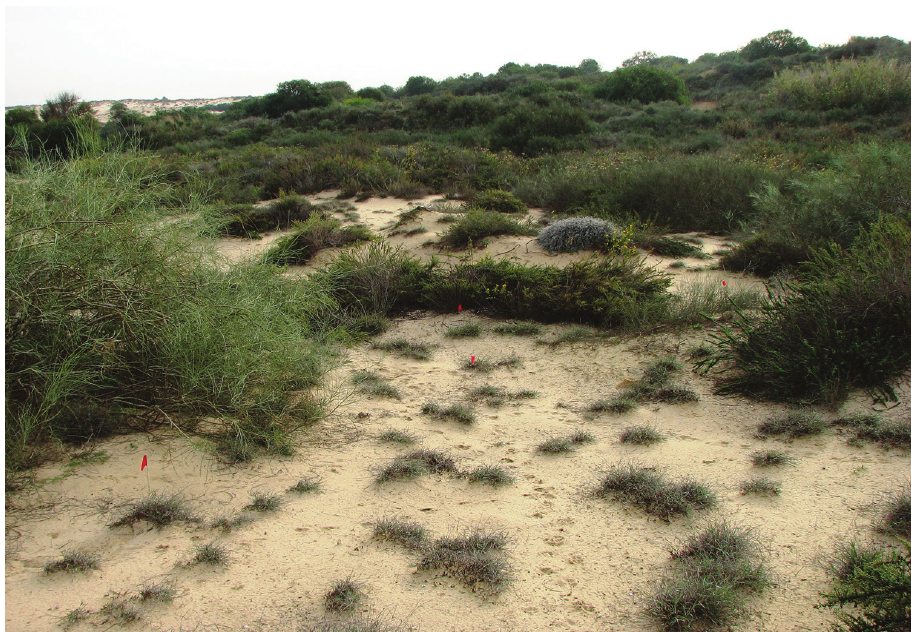
Figure 15. Habitat of Graphipterus sharonae sp. n.: Stabilized sand dunes with rich vegetation. Nizzanim, Israel.